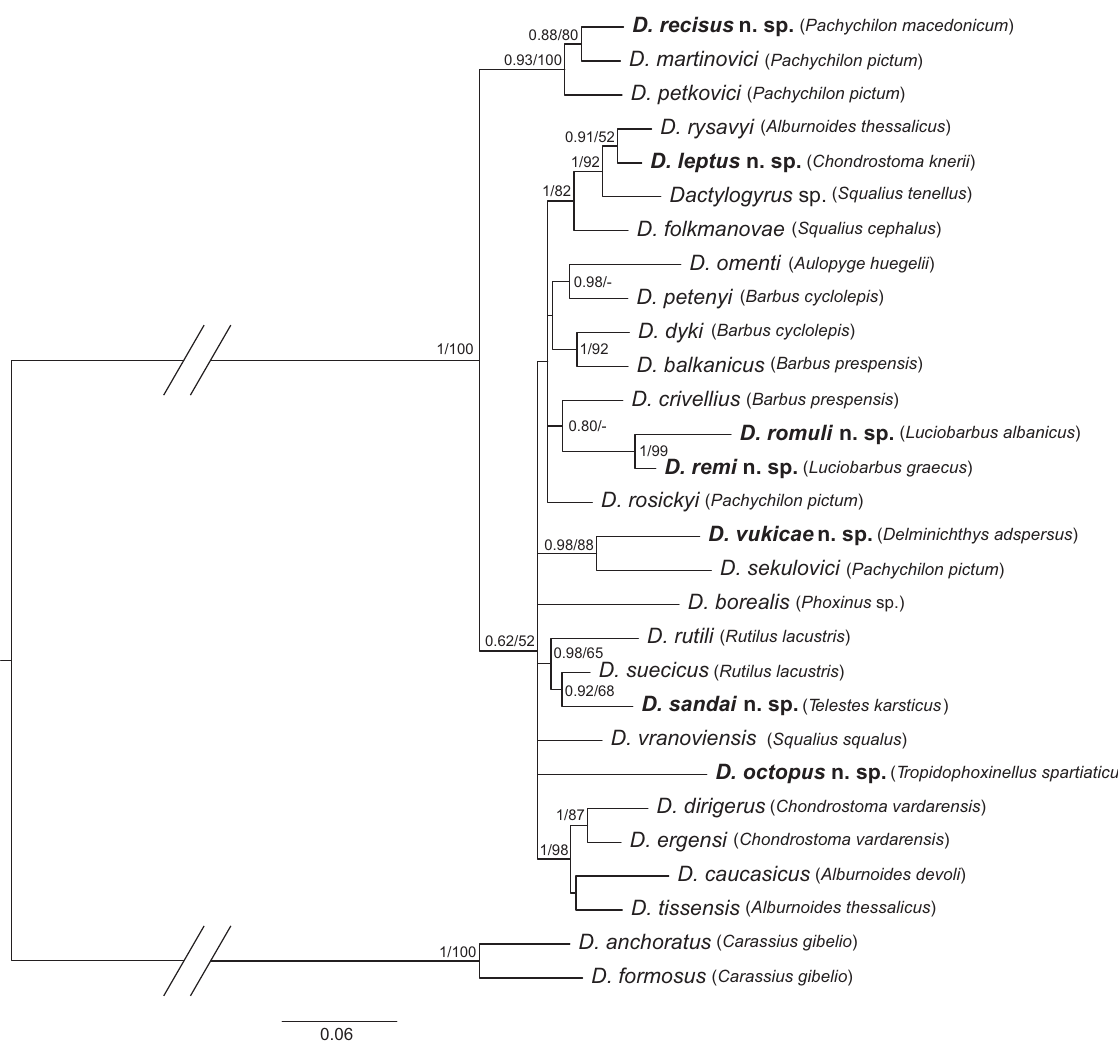
Dactylogyrus vukicae n. sp. was phylogenetically proximal to Dactylogyrus sekulovici Ergens, 1970 from P. pictum . Dactyl- ogyrus sandai n. sp. grouped with D. suecicus and D. rutili (both common species of Rutilus spp.), which share similar morphological features with the newly described species.